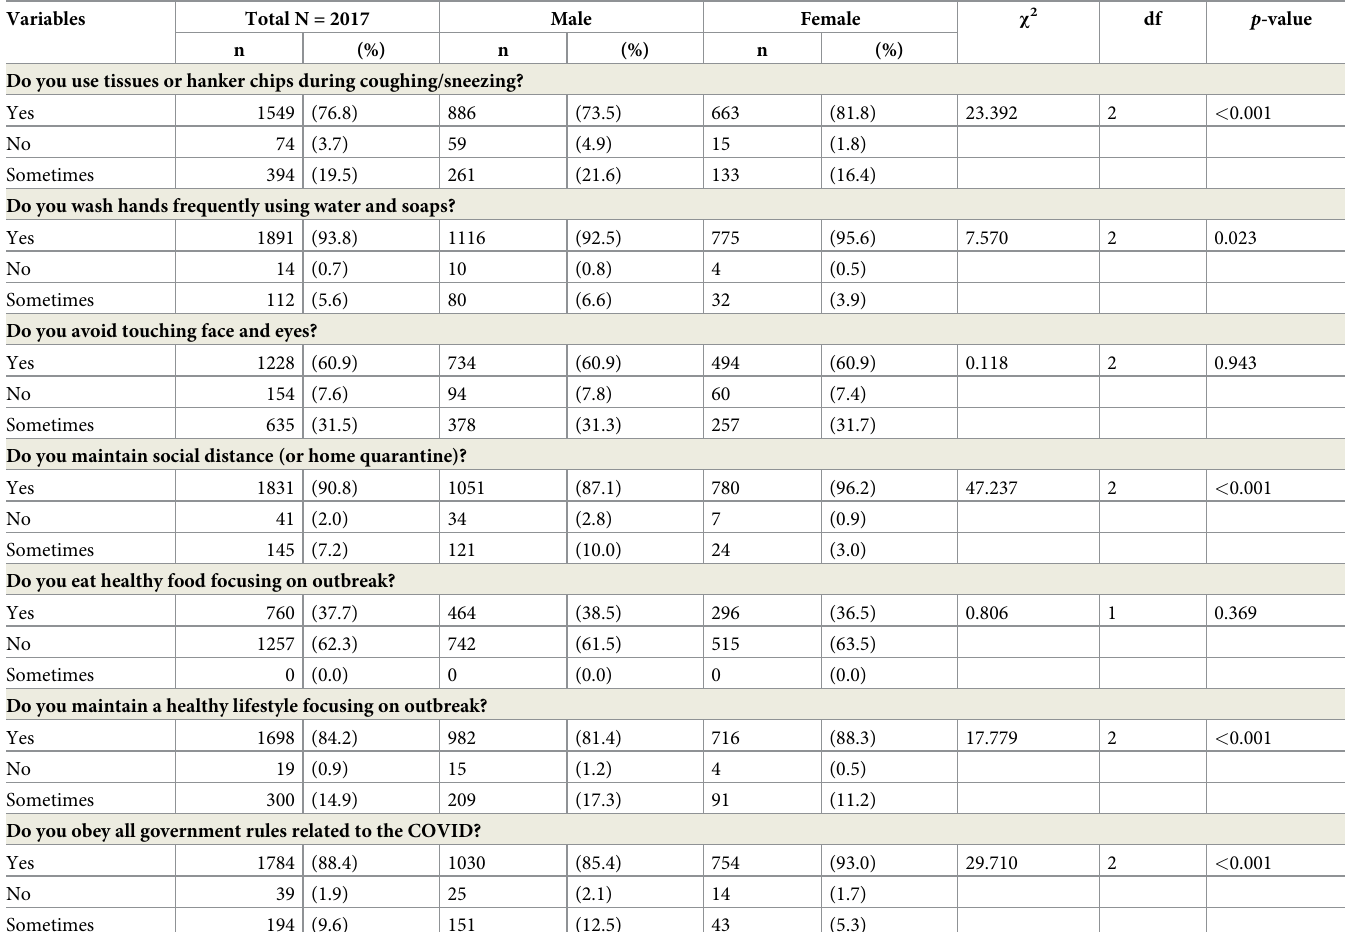
Table 5. Practice and gender difference of participants (N =